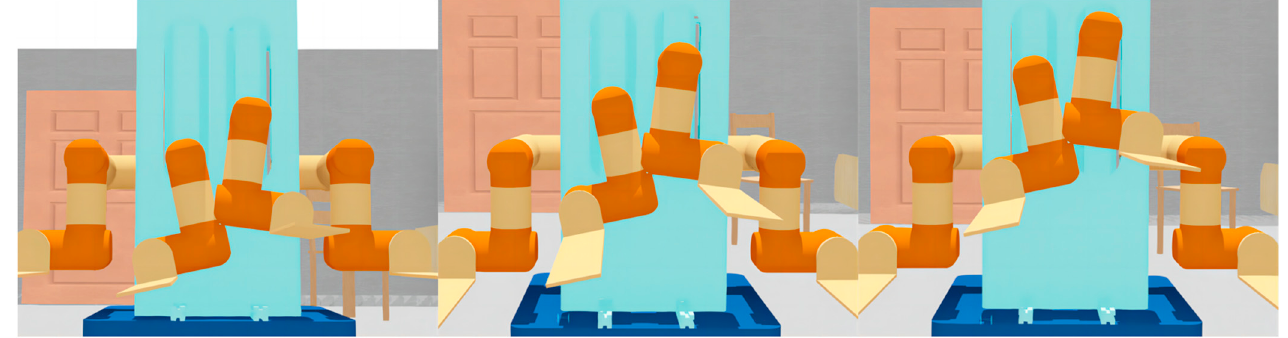
Figure 11. Dual-manipulator LF-RF lift the same height at the same